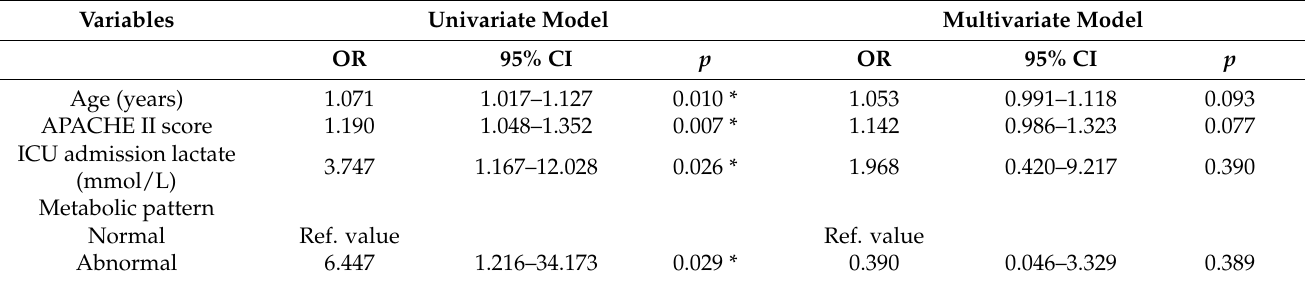
Figure 3. Plot of ICU admission lactate levels and lactate-to-pyruvate (LP) ratio in COVID-19 patients. The LP ratios are given in the y -axis and lactate levels on the x -axis. Horizontal line, LP ratio = 10; vertical line, lactate = 2 mmol/L. Table 3. Odds ratios and 95% confidence intervals for the possible prognostic factors of mortality in our cohort of critically ill COVID-19 patients.